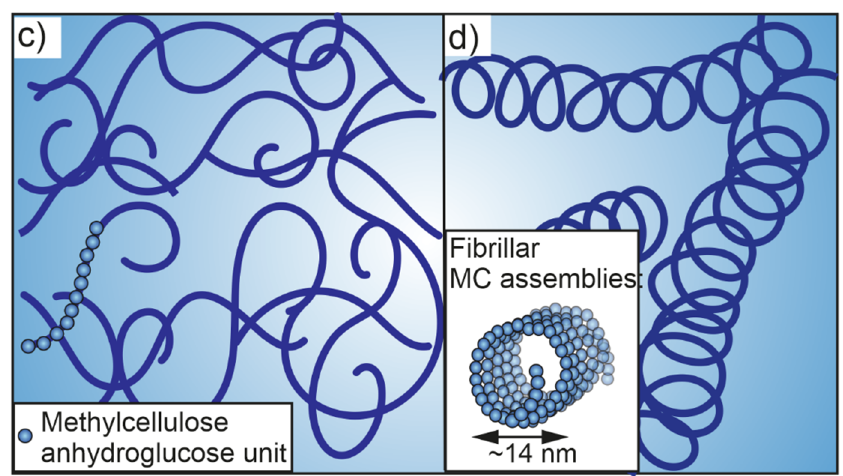
Figure 1. Methylcellulose. ( a ) Chemical structure of methylcellulose repeat unit. ( b ) Photographs of 1% MC aqueous solution at 22 °C and 60 °C. Due to the LCST behavior, MC turns into a turbid gel at elevated temperatures. ( c , d ) Schematics of aqueous MC polymer chain (blue line corresponds to MC polymer chain) behavior at 22° and 60°, respectively. The blue spheres in ( c , d ) correspond to the methylcellulose anhydroglucose unit, i.e., components of the polymer chain, whose structural formula is presented in ( a ). Figure ( c , d ) is adapted with permission from [31], (https://pubs.acs.org/doi/full/10.1021/acs.biomac.8b00392, date accessed 3.9.2021). Copyright 2018 American Chemical Society.